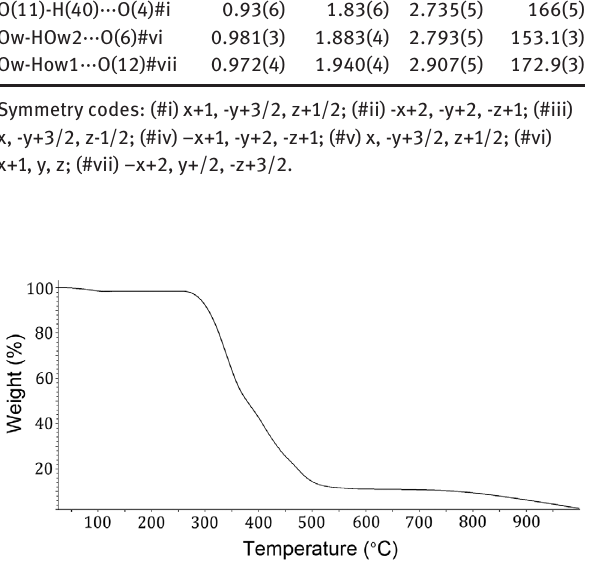
Figure 3: Thermogravimetric curve of [Zn(L)( H